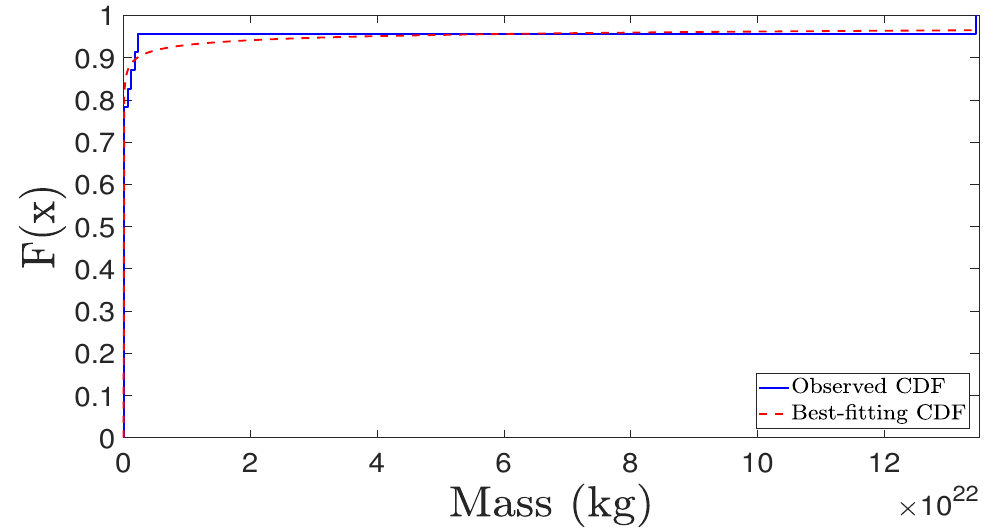
Figure 1. The mass CDF of Saturn’s regular moons and the corresponding CDF of the best- fitting